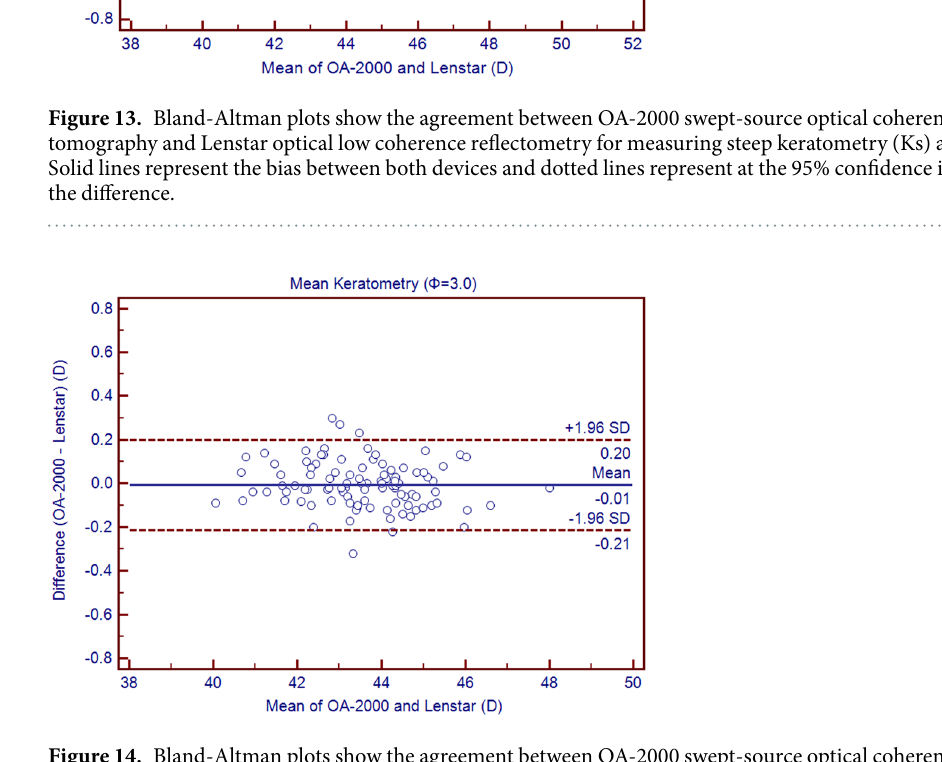
Figure 14. Bland-Altman plots show the agreement between OA-2000 swept-source optical coherence tomography and Lenstar optical low coherence reflectometry for measuring mean keratometry (Km) at 3.0 mm. Solid lines represent the bias between both devices and dotted lines represent at the 95% confidence interval for the